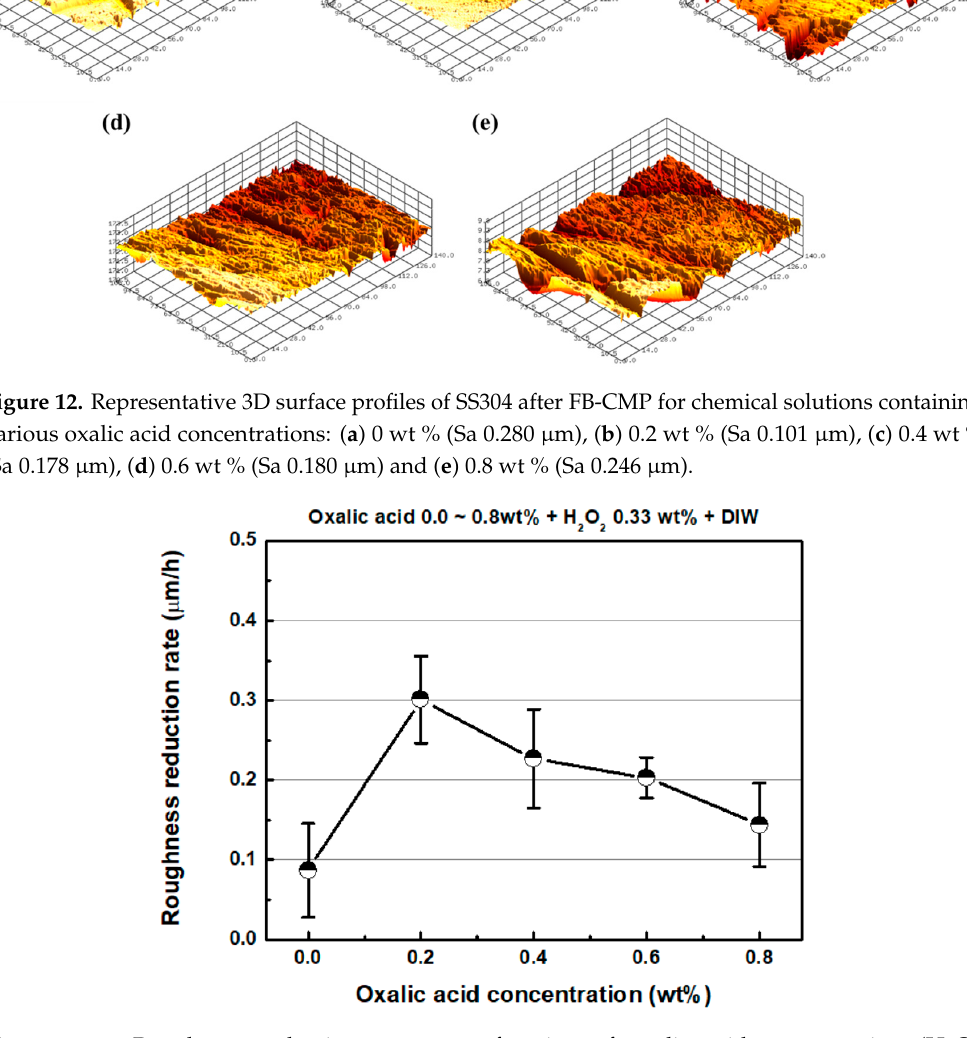
Figure 13. Roughness reduction rate as a function of oxalic acid concentration (H 2 O 2 concentration: 0.33 wt %).